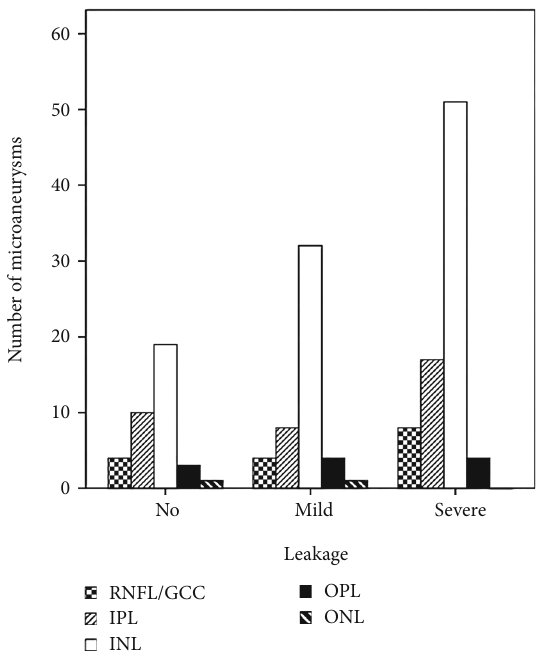
Figure 5: Distribution of the center of diabetic microaneurysms ( N = 167 ) by retinal layers. RNFL: retinal nerve fi ber layer; GCC: ganglion cell layer; IPL: inner plexiform layer; INL: inner nuclear layer; OPL: outer plexiform layer; ONL: outer nuclear